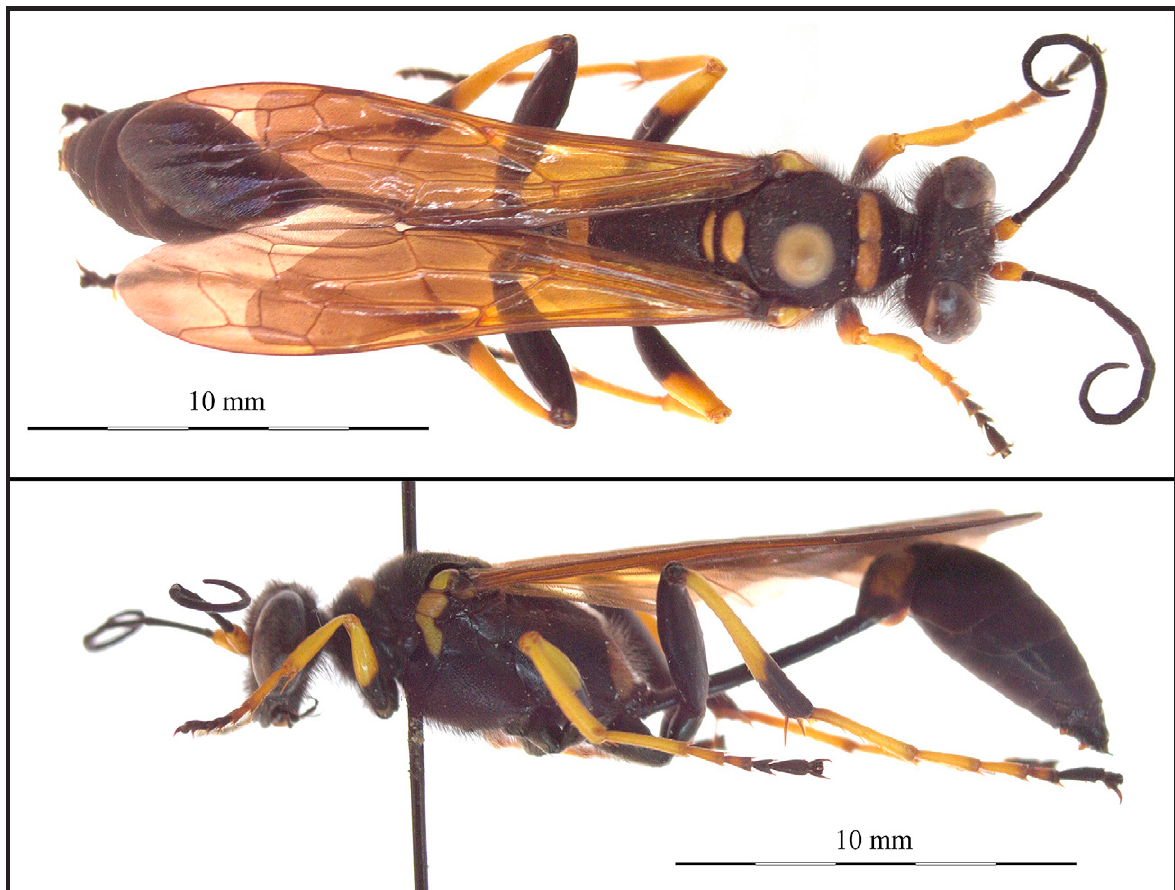
Figure 1. Sceliphron caementarium (Drury, 1773), ♀♀ specimen deposited at the ZMUA. A. Dorsal view. B. Lateral view. Scale bar = 10 mm. Note the completely black hind femora, yellow scapus and